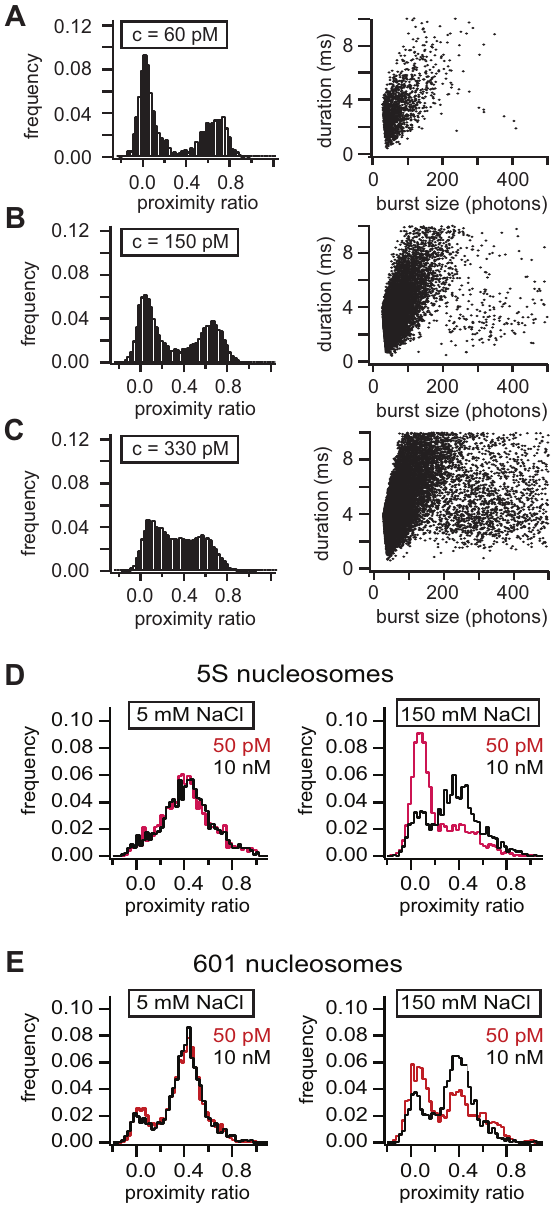
Figure 2. Working range of conventional and quasi-bulk single particle FRET. A – C ) smFRET histograms and burst size to burst duration distributions for a binary DNA mixture (noFRET and FRET- active) at 60 pM (A), 150 pM (B), and 330 pM (C) sample concentrations. While at 60 pM both subpopulations are clearly separated, coincident detection of both species occurs at 150 pM and above. The presence of multi-particle events is evident from the burst size to burst duration distribution. While at 50 pM burst duration and burst size strongly correlate, additional populations appear outside the ellipsoidal point cloud at higher sample concentrations. D, E ) Principle of quasi-bulk smFRET of nucleosomes. Nucleosomes were reconstituted on 5S rDNA (D) or the high affinity Widom 601 sequence (E). Histograms are shown for 5 mM or 150 mM salt concentrations and in the presence or absence of 10 nM unlabeled nucleosomes. At 5 mM NaCl (left panels) most nucleosomes were intact as expected from Figure 1A. At 150 mM NaCl (right panels) and in the absence of unlabeled nucleosomes, diluted nucleosomes dissociated, whereas under quasi-bulk conditions, nucleosomes on both 5S and 601 DNA remained